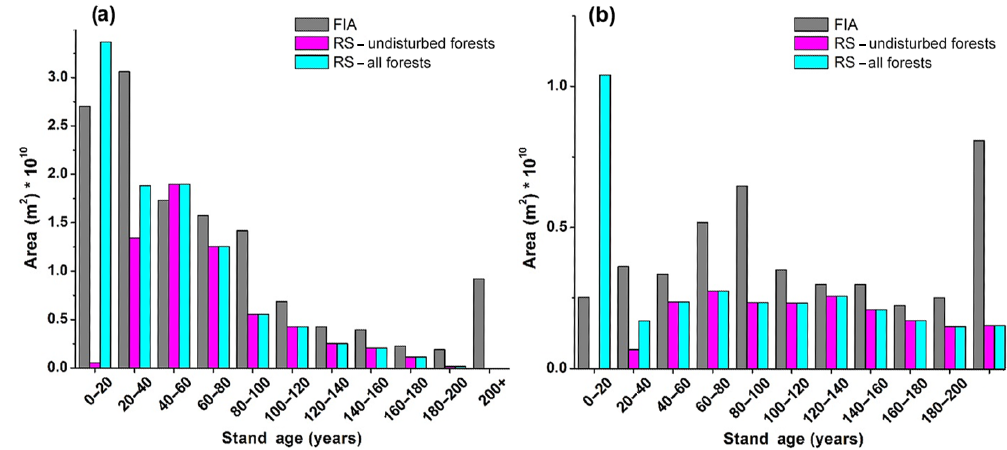
Figure 10. Distribution of forest area by age for (a) Douglas-fir and (b) fir–spruce–mountain hemlock of the PNW region comparing results from FIA data and remote-sensing-derived (RS) estimates for undisturbed and all forests, including those marked as disturbed in NAFD, ADS, and MTBS datasets and shown here as if they were stand-clearing